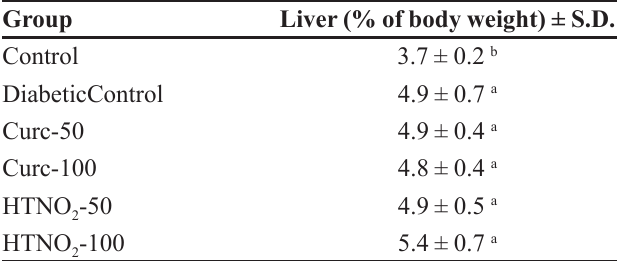
TABLE III - Mean values for animails liver weight. Data compared to total body weight, divided in experimental groups Group Liver (% of body weight) ± S.D.